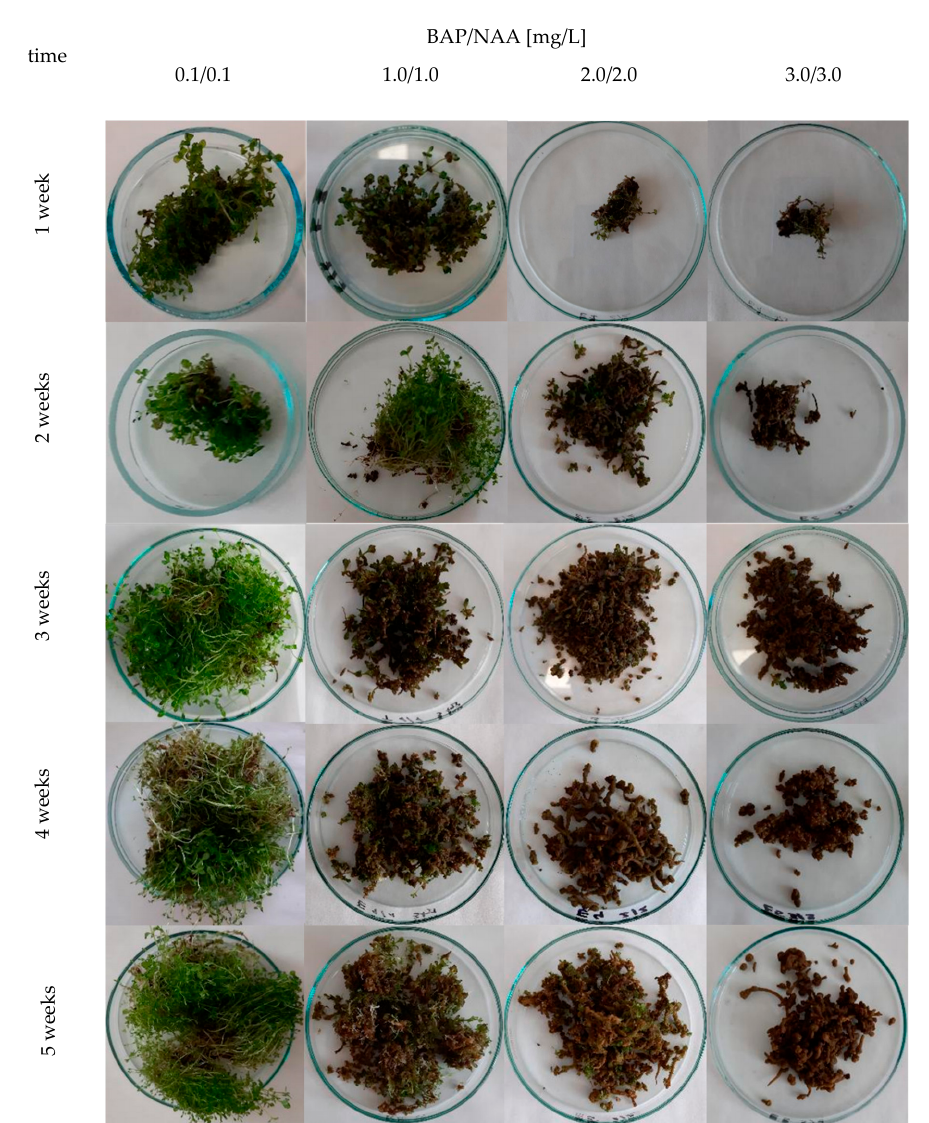
Figure 2. Morphology of microshoots from agitated H. perforatum cv. Elixir in vitro cultures depending on the concentration of PGRs tested (BAP and NAA) [mg/L] in a MS medium variant during 5-week growth cycles.